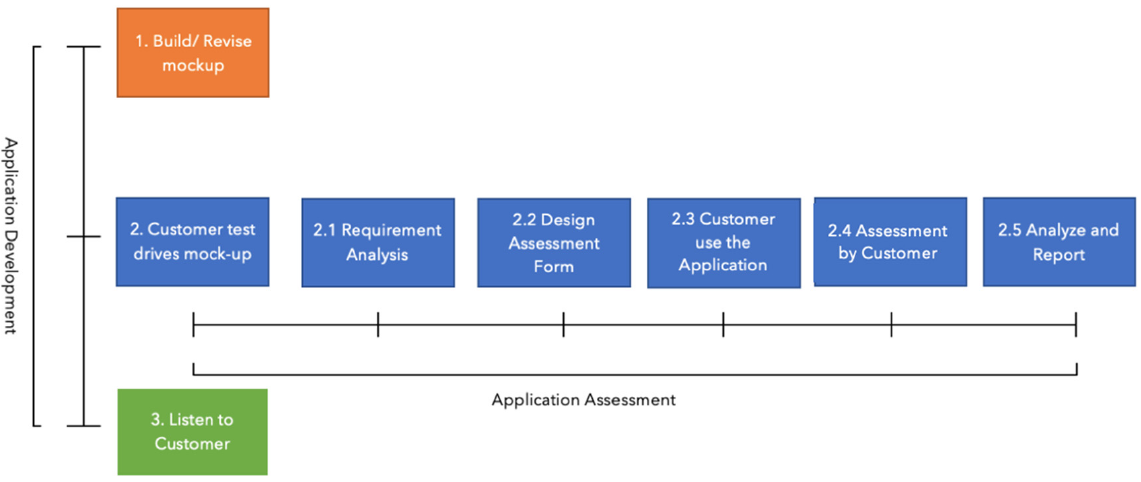
Figure 2. Application Development and Assessment Process. Table 6. Application Development and Assessment.